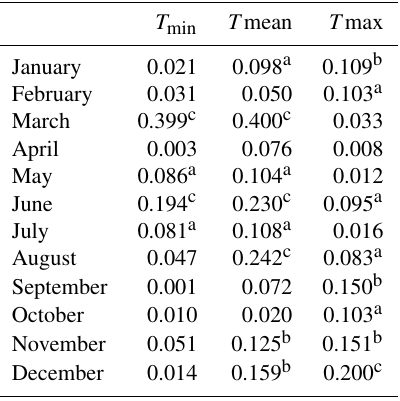
Table 10. Relationship ( R 2 ) of snow depth (cm) and monthly T min , T mean and T max from 1979 to